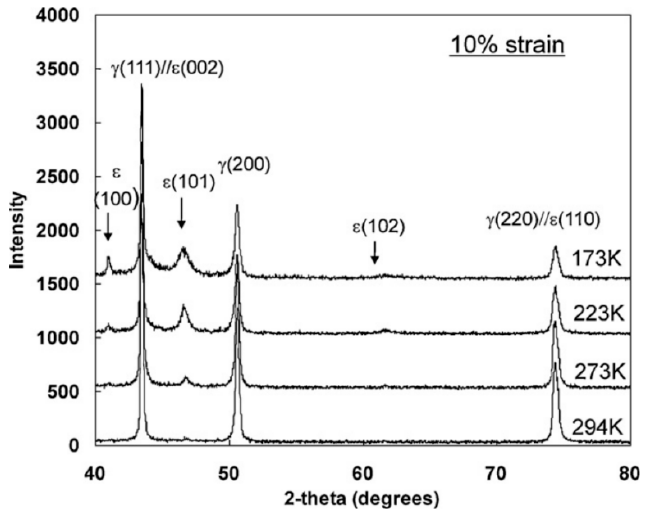
Figure 6. The X-ray diffraction of the Fe–17Mn–0.6C alloy in the temperature range of 173–294 K (Reprinted with permission from Ref. [10], Copyright 2022 Elsevier).